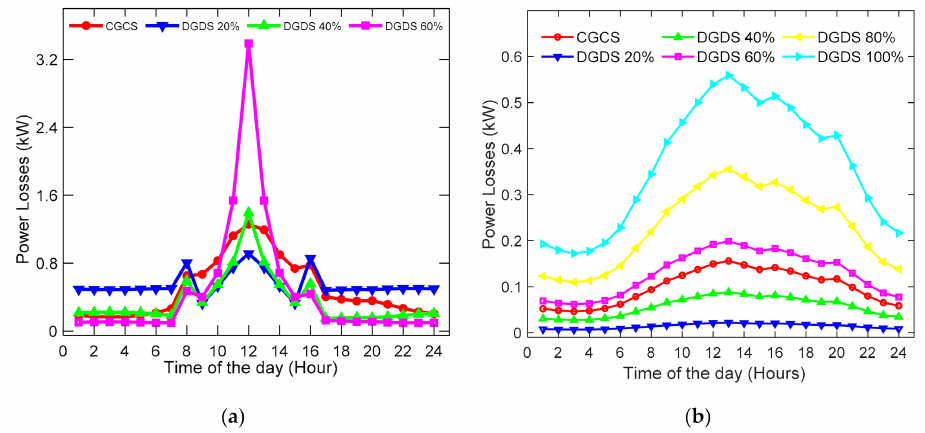
Figure 11. ( a ) Time-varying power electronic conversion losses of CGCSA vs. DGDSA at variable power-sharing ( b ) time-varying distribution losses of CGCSA vs. DGDSA at variable